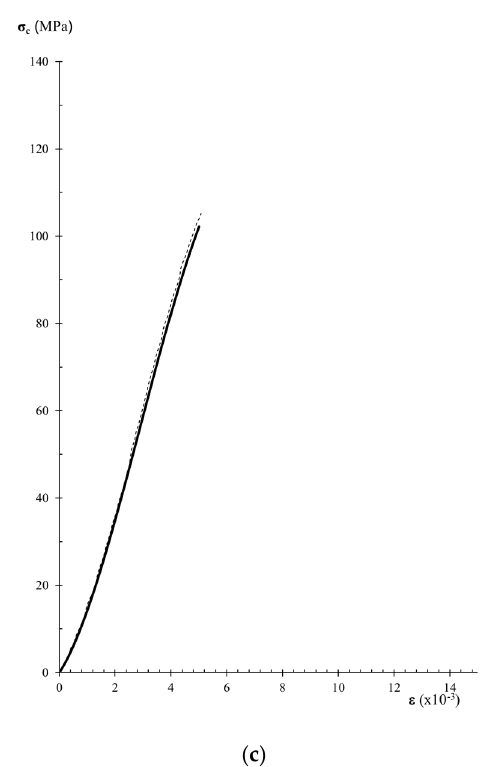
Figure 7. Analytical modeling of results of curves of variety A sandstone specimens. The dashed black curves are the stress-strain diagrams of experimental results, and the thicker black curves are the analytical stress–strain diagrams: ( a ) Specimen APN; ( b ) Specimen AP9; ( c ) Specimen AP5.